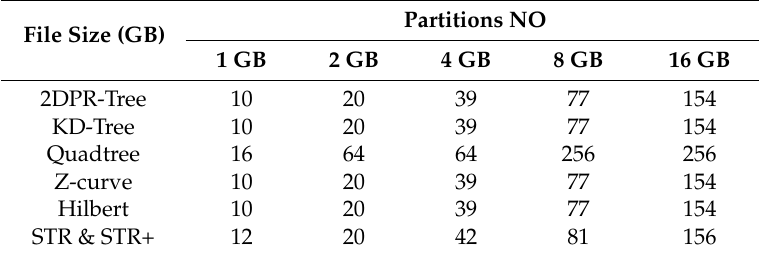
Table 4. Partition number generated by indexing techniques in the synthetic datasets.